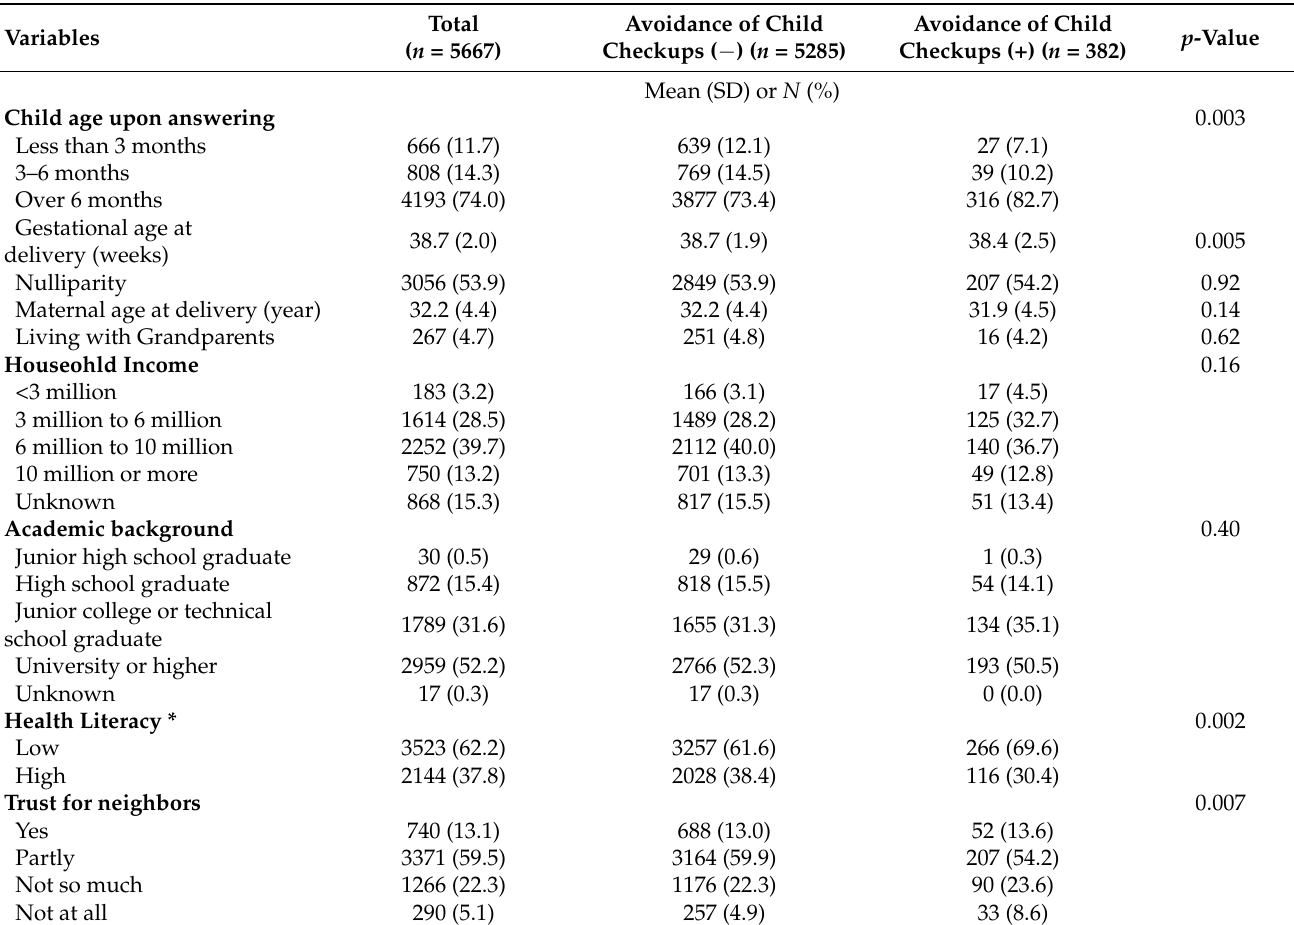
Table 1. Demographics stratified by avoidance of health checkups for